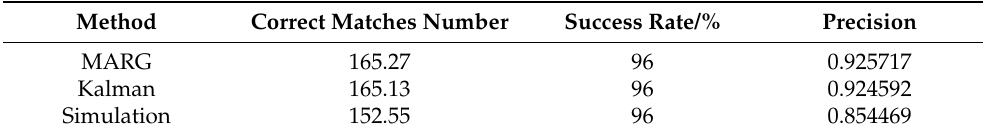
Table 7. Performance comparison under IMU